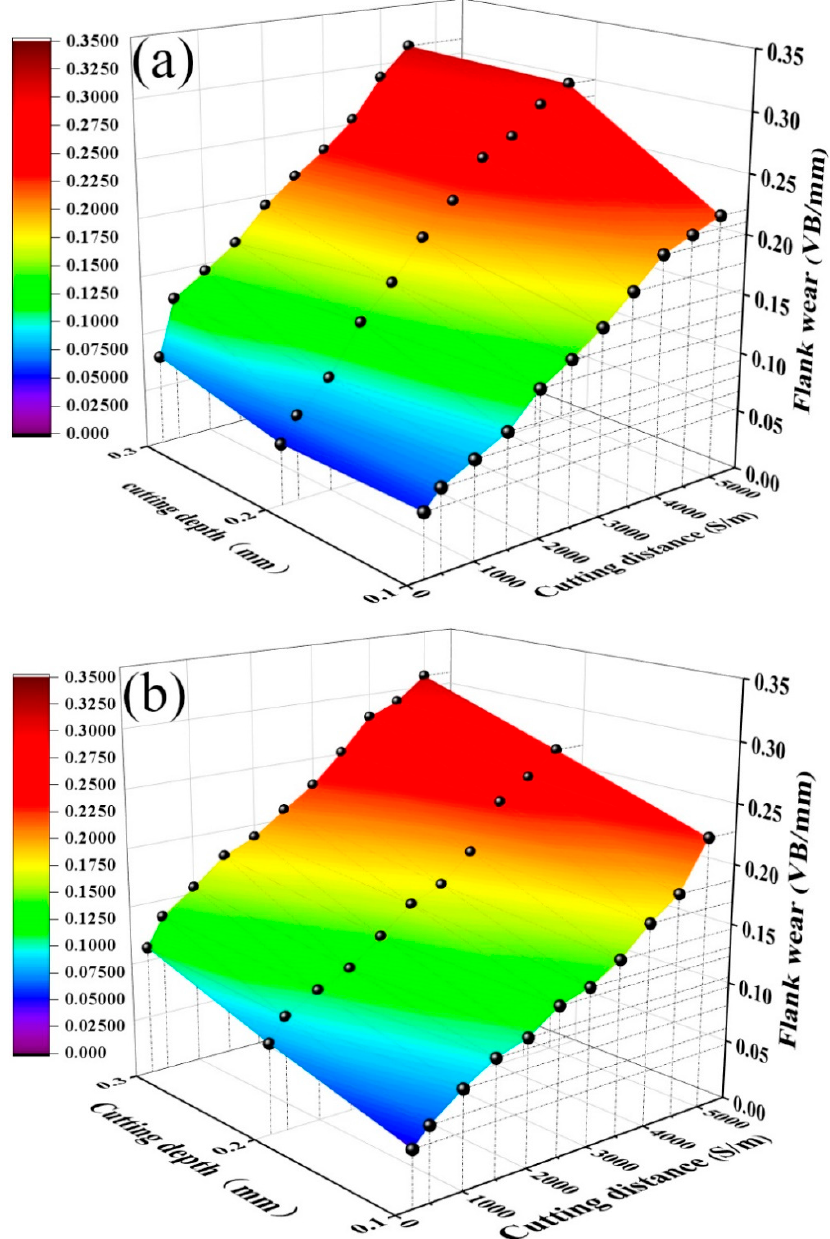
Figure 8. Curves of flank wear VB against cutting distance S at different cutting depths: ( a ) ATS, ( b ) ATSC10.